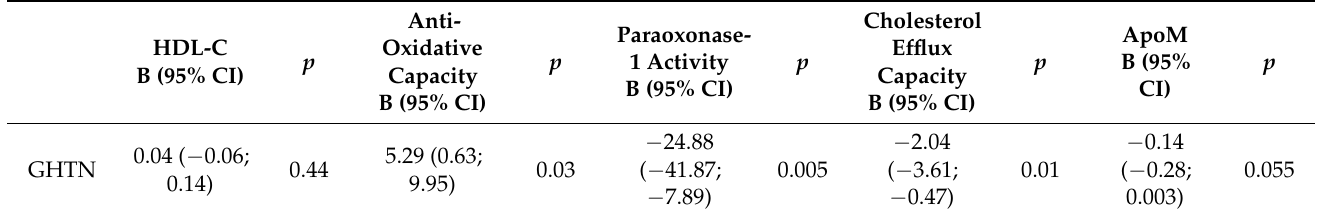
Table 2. Linear regression models of the association of GHTN with cord blood HDL-parameters.